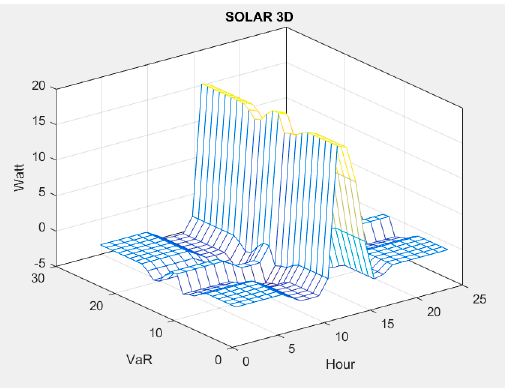
Figure 10. Power generation of PVs for the different risk levels.